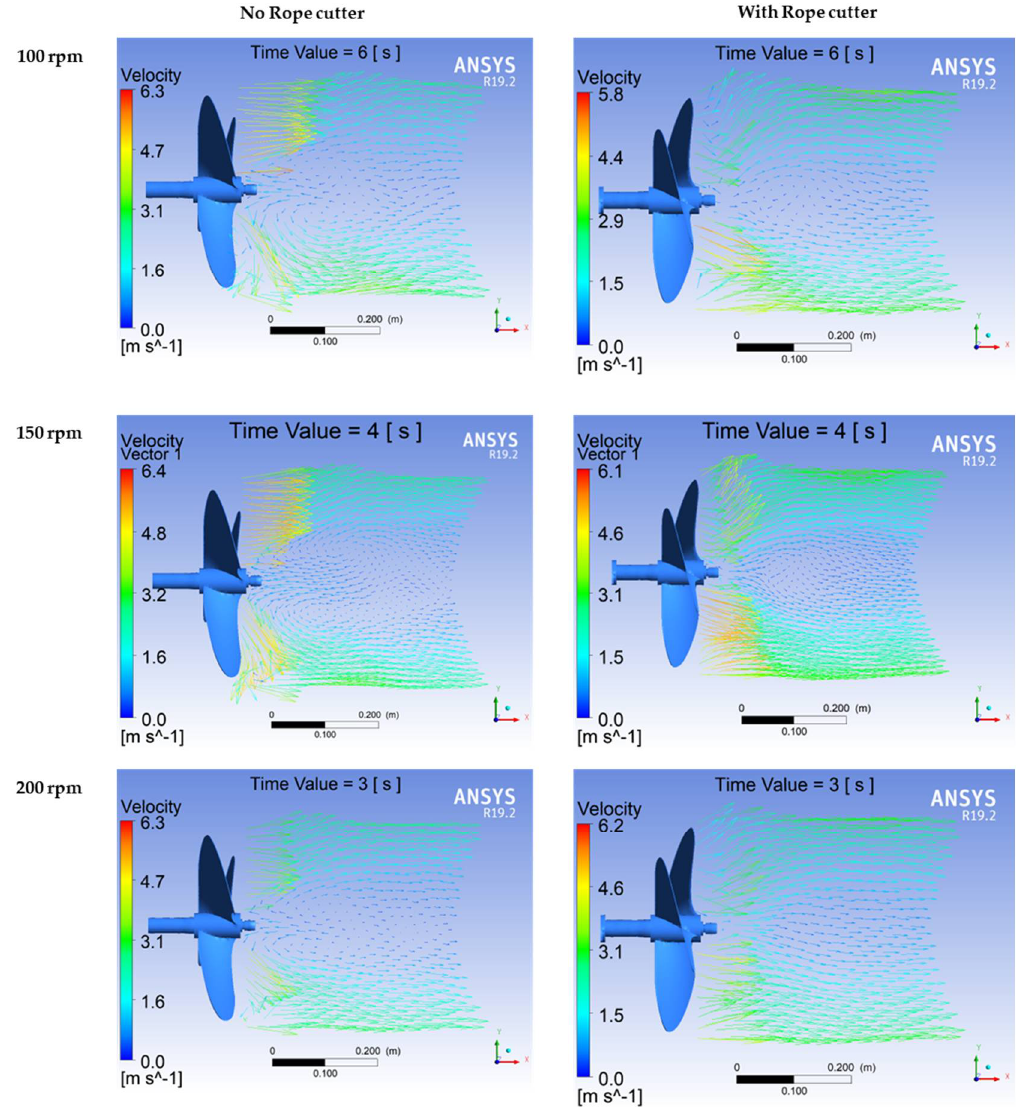
Figure 22. Velocity vector maps of the water flow behind the propeller [m/s].